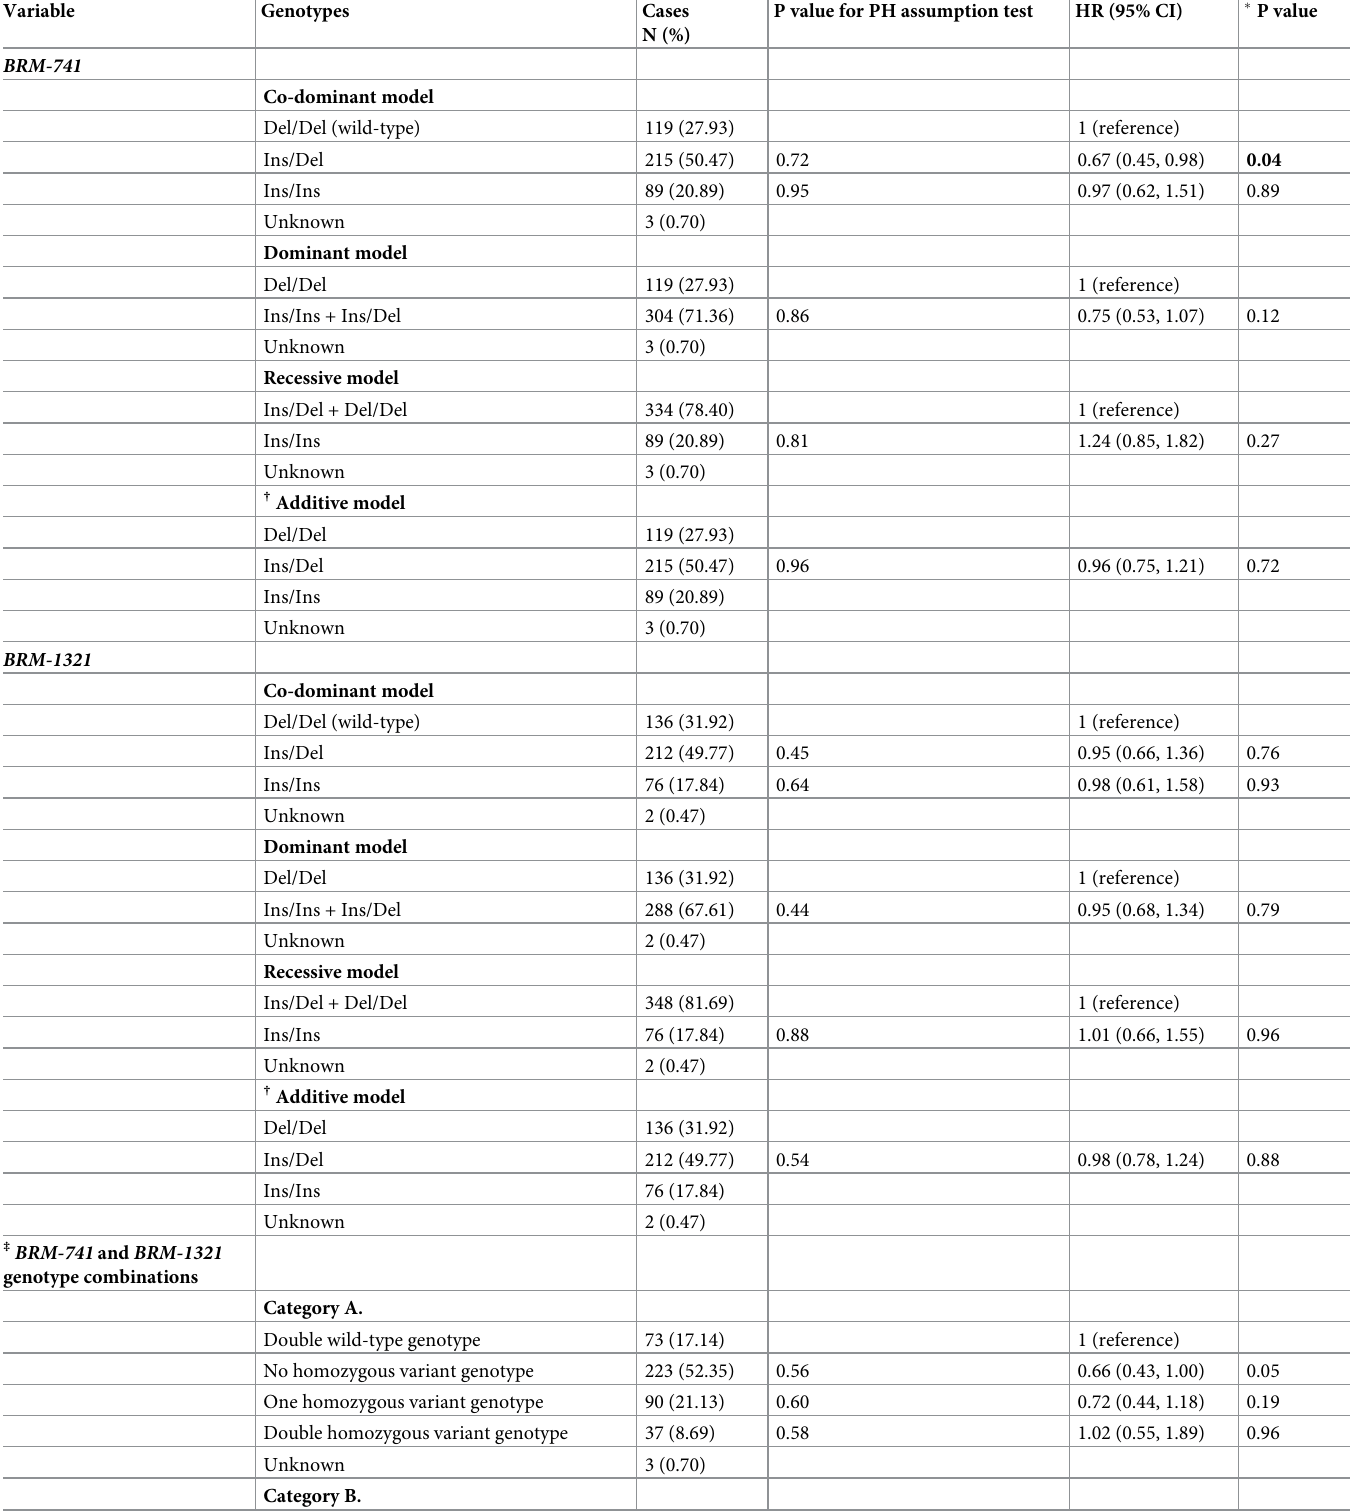
Table 4. BRM promoter indels and progression-free survival in colorectal